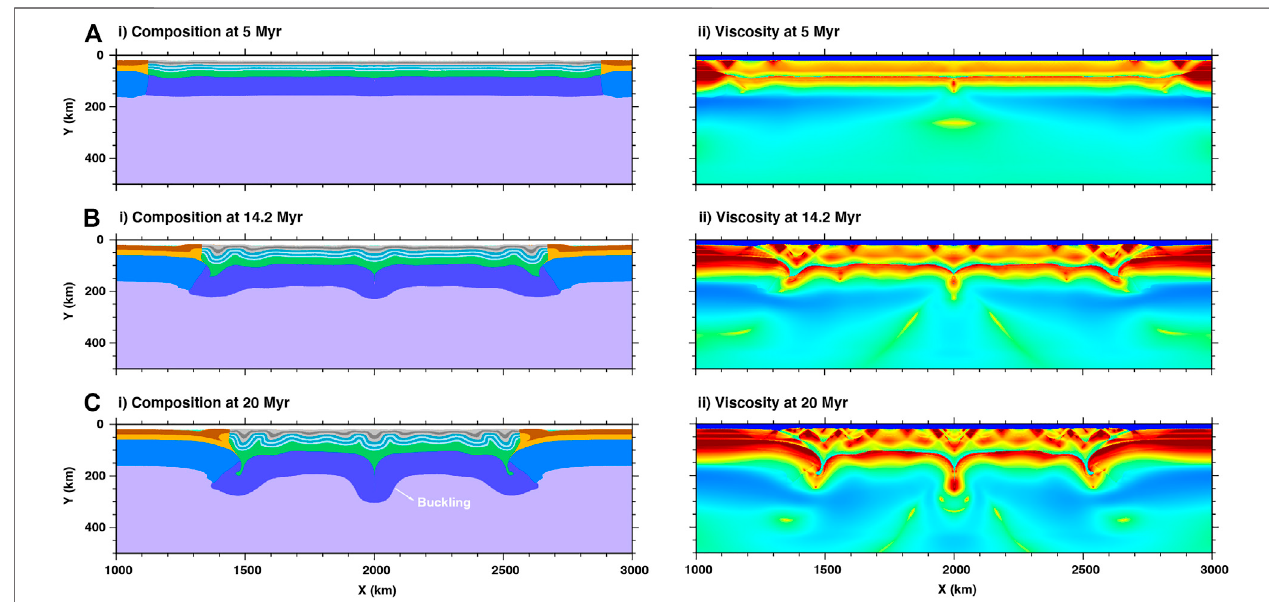
FIGURE4| Timeevolutionofthemodel “ delc ” ,inwhichtheorogenlowercrustrheologyisrepresentedby “ plagioclase ” . (Ai – C) compositionevolutionforselected model times (colors as in Figure 2 ). (Aii – Cii) viscosity distribution for selected model times (colors as in Figure 3 ).